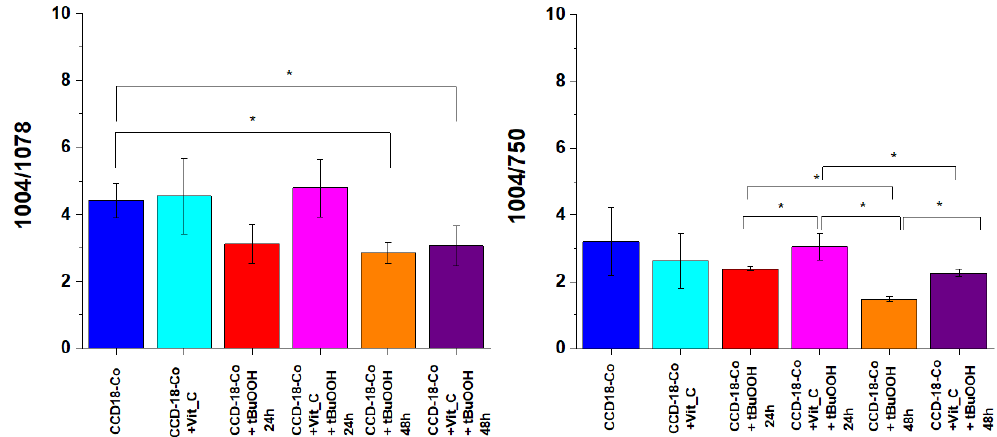
Figure 11. Raman band intensities ratios for selected Raman bands corresponding to nucleic acids for six groups of normal human colon cells CCD-18 Co: control group (labeled CCD-18 Co, blue), group supplemented with vitamin C (labeled CCD-18 Co+Vit_C, turquoise), group supplemented with tBuOOH for 24 h (labelled CCD-18 Co+tBuOOH, 24 h, red), group supplemented with vitamin C and tBuOOH for 24 h (labelled CCD-18 Co+Vit C+tBuOOH, 24 h, magenta), group supplemented with tBuOOH for 48 h (labelled CCD-18 Co + tBuOOH, 48 h, orange), group supplemented with vitamin C and tBuOOH for 48 h (labelled CCD-18 Co +Vit C + tBuOOH, 48 h, violet); the statistically significant results, based on ANOVA analysis, have been marked with asterix.